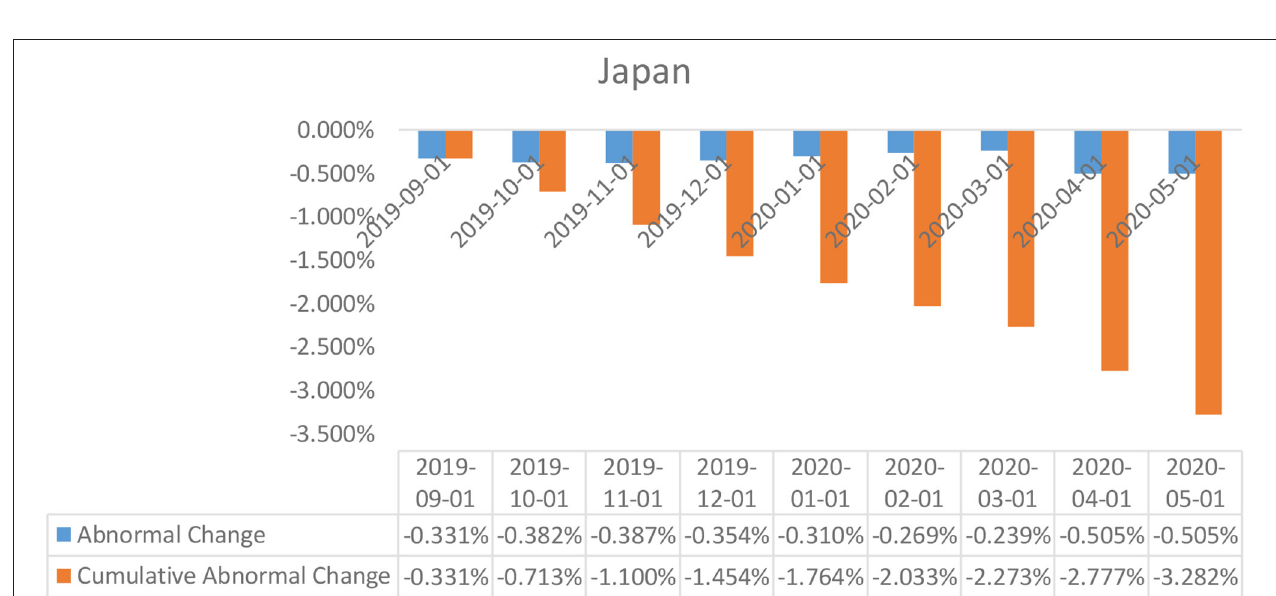
FIGURE 2 | Abnormal changes in policy interest rates over the event window: United Kingdom.